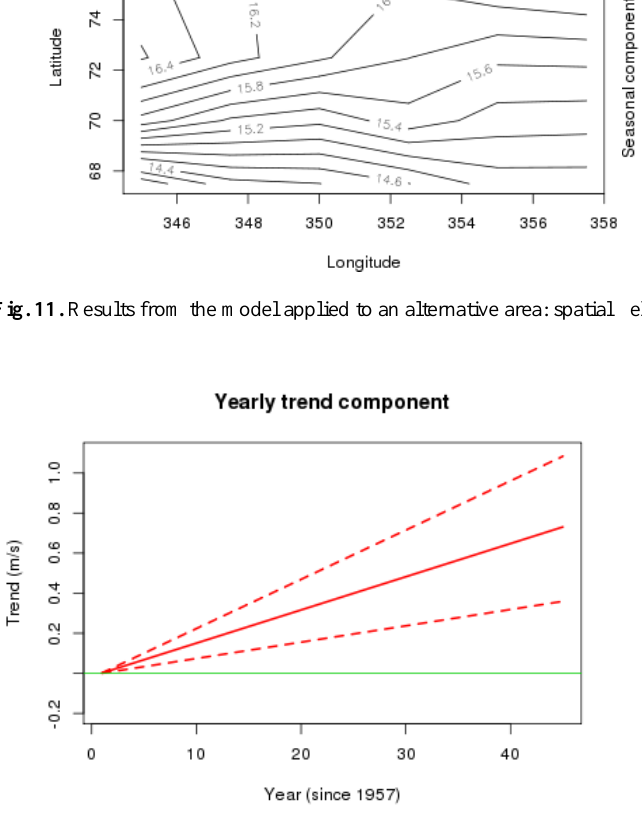
Fig. 12. The estimated mean trend for the area north of Island with 90% credible intervals